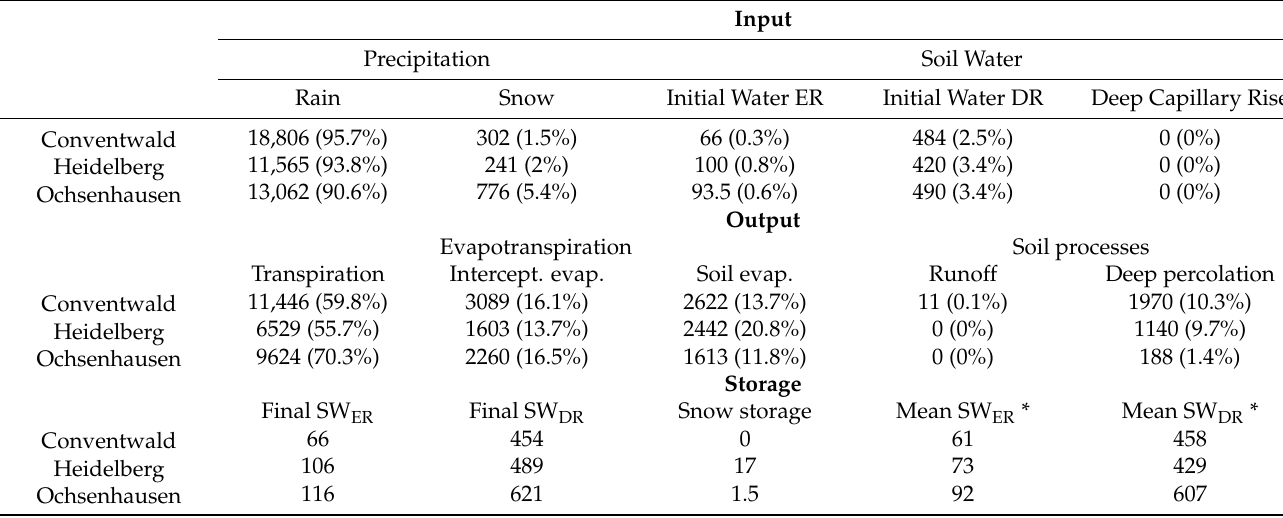
Table 3. Water balances over the whole periods at all three stands. All values in (mm), (%) indicating the share of input or output, respectively. (*) mean SW ER and SW DR are not part of the balance (storage) but displayed for interpretation